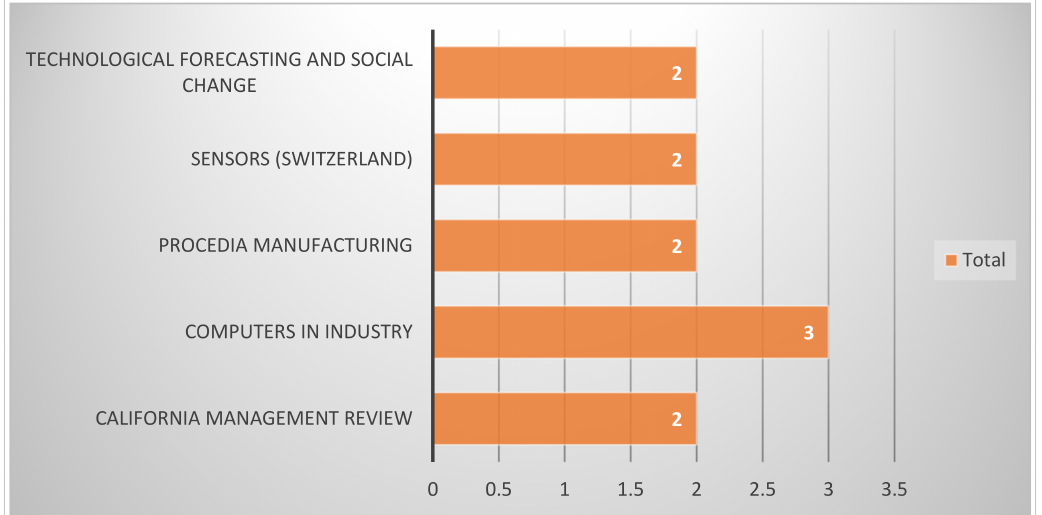
Figure 4. The highest publications from the